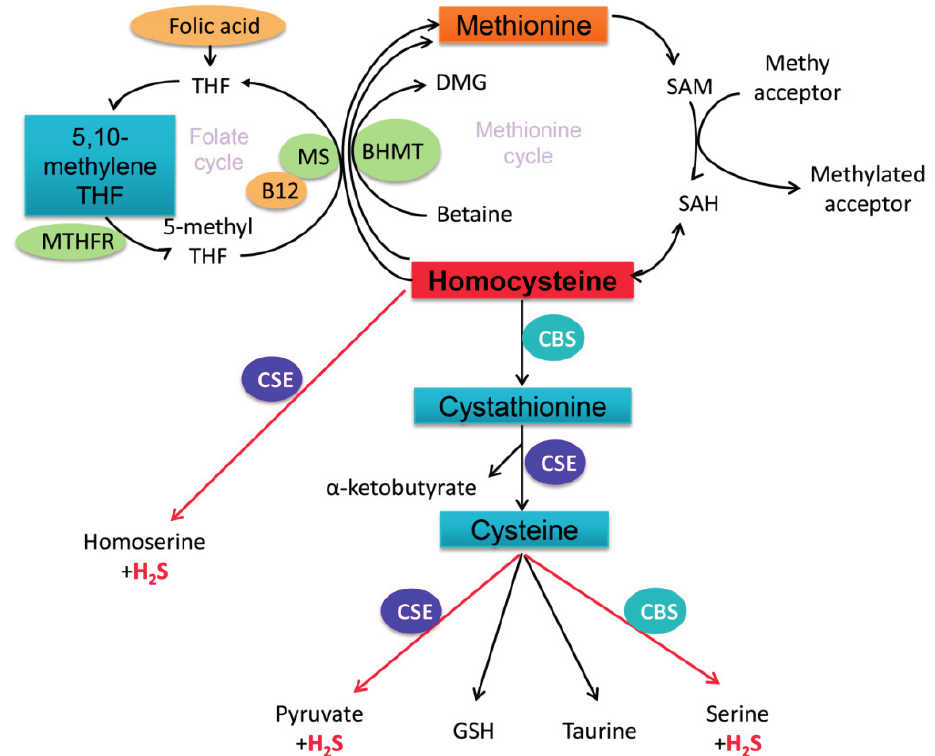
Figure 6. Schematic representations of mammalian homocysteine